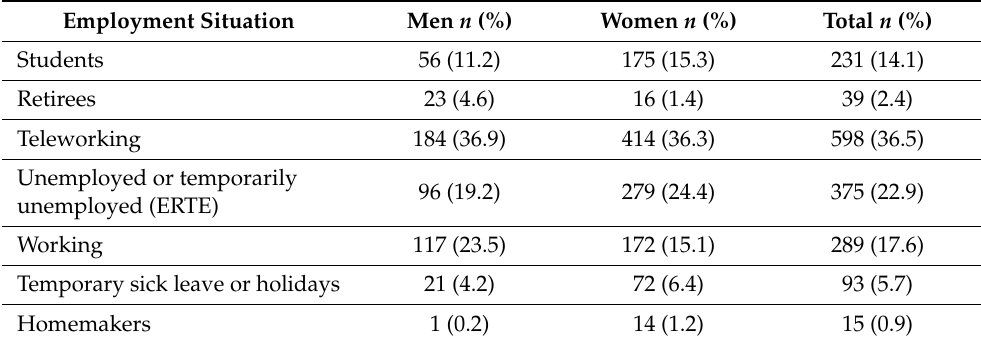
Table 1. Description of the employment situation of the Spanish population during the COVID-19 pandemic confinement, for the total sample and by